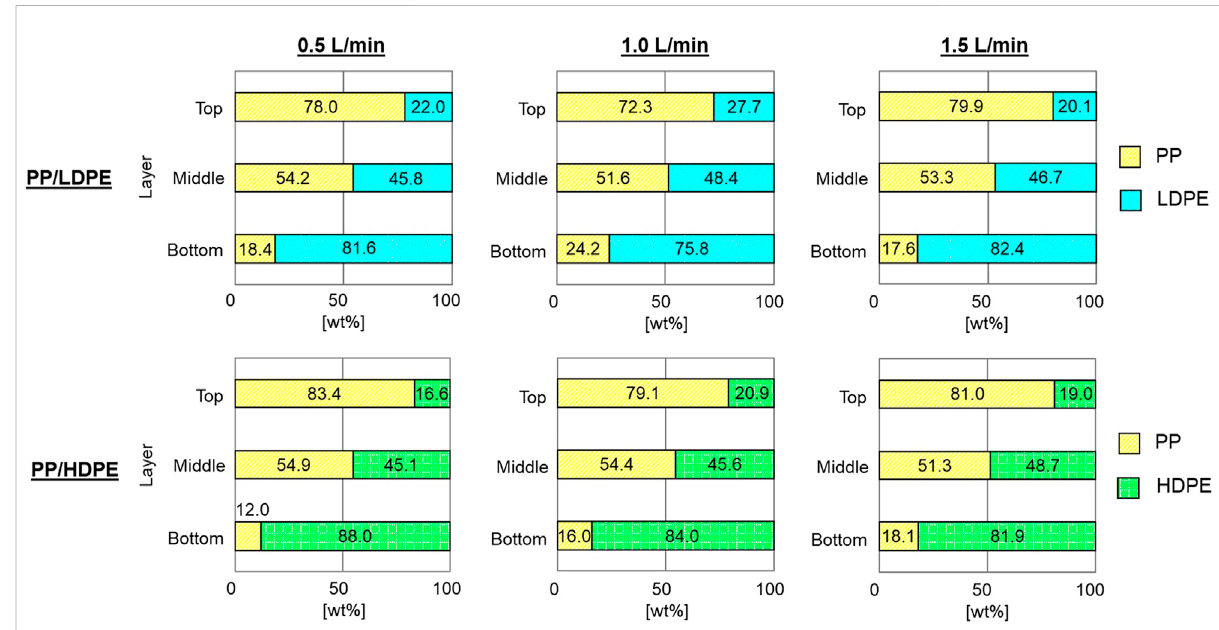
FIGURE 7 Theproportion ofplastics ineachlayerafterreverse hybridjigseparationofPP/LDPE andPP/HDPEwithoutbubble generationduringpulsation at different air fl ow rates of 0.5, 1.0, and 1.5 L/min in water (i.e., without wetting